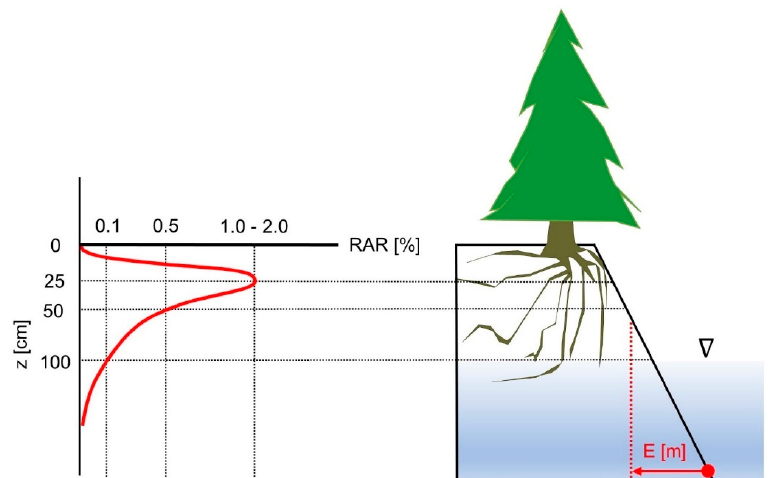
Figure 3. Conceptual illustration of how BankforNET models hydraulic bank erosion considering RAR. The density of the RAR is a function of rooting depth and roots protecting the streambank affected by the flow. On the left is a conceptual illustration of root density (i.e., RAR) as a function of rooting depth. The red dot and arrow on the right represent the one-dimensional erosion at the bank toe that is modeled by BankforNET considering the vertical RAR distribution if roots are present. If no discharge data is available, peak discharge 𝑄 (cid:3040)(cid:3028)(cid:3051) (m 3 /s) for different return periods is estimated based on a modified and adapted empirical relation proposed by Kölla [73]: 𝑄 (cid:3040)(cid:3028)(cid:3051) = (cid:4670)𝑙𝑛(𝑅𝑃) + 6.38(cid:4671) 𝐴 (cid:3030)(cid:2868).(cid:2874)(cid:2869) where 𝑅𝑃 is the return period (year) and 𝐴 (cid:3030) is the catchment area (km 2 ). The function in brackets substitutes rainfall intensity in the equation from Kölla [73] for different scenarios (return periods) and was established based on observed data. The presented empirical equation was developed specifically for this model framework and was calibrated using observed precipitation and discharge data. Event duration 𝑇 (min) is then also estimated empirically based on data from Marchi et al. [74], defining the duration of the discharge event as a power function of catchment area (km 2 ): 𝑇 = 298 𝐴 (cid:3030)(cid:2868).(cid:2871)(cid:2873)(cid:2873) (9) In BankforNET, a triangular shape is used to represent the hydrograph, as proposed by the US soil conservation service (SCS) [75]. This approach allows the framework to be applicable for multiple catchments without calibration of the hydrograph. 2.2. Case Studies 2.2.1. The Selwyn/Waikirikiri River Catchment Stecca et al. [28] presented a framework for the analysis of noncohesive hydraulic bank erosion algorithms. In their article, they assessed the performance of different “candidate” hydraulic bank erosion models by applying the different models to a case study: The Selwyn/Waikirikiri River flows southeast from the foothills of the Southern Alps in the South Island of New Zealand into Lake Ellesmere/Te Waihora (43°30 ′ 18 ″ S, 171°58 ′ 54 ″ E). In 2008, a single flood event with a duration of 38.9 h, where the river was morphologically active, peak discharge of ~130 m 3 s − 1 occurred. During this event, the right streambank at an investigated cross section experienced 15.00 m of retreat. Based on a pre- and post-flood digital elevation model (DTM), the models were tested (Table 2). The duration of the modeled hydrograph was reduced to 38.9 h; during this time the river was morphologically